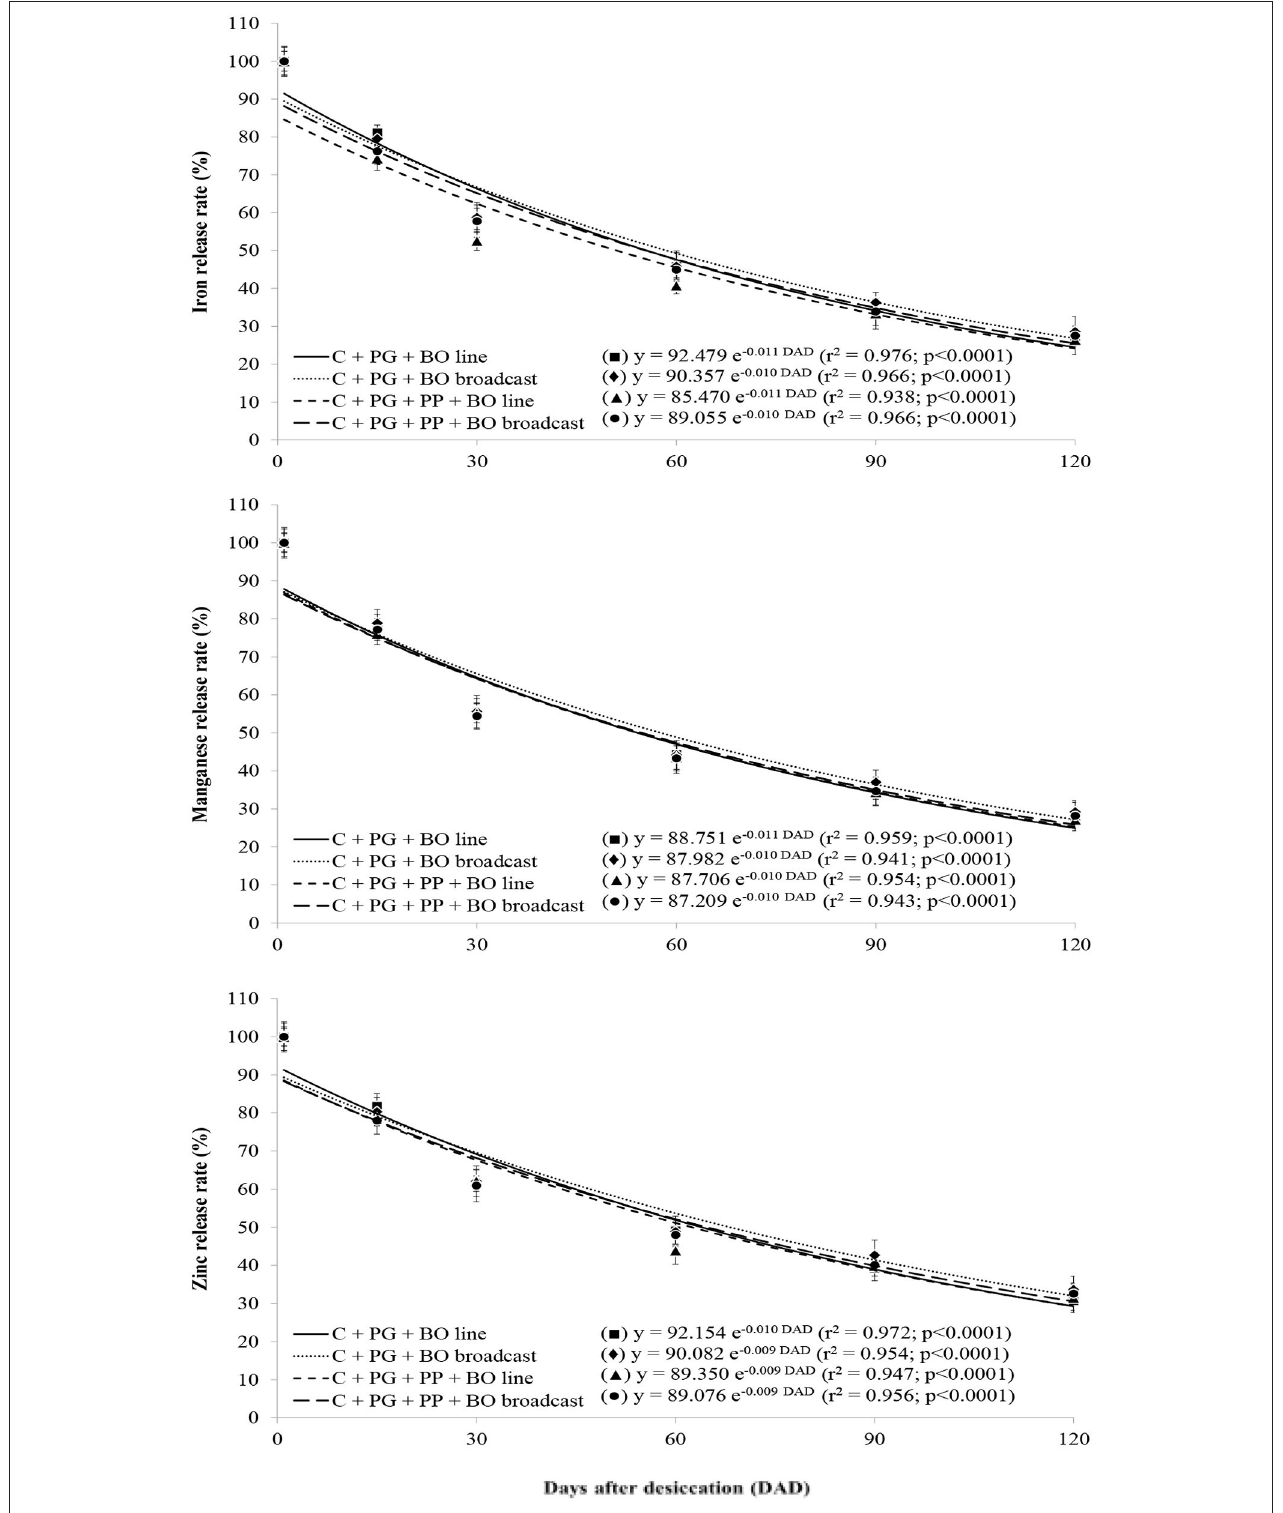
FIGURE 4 | Release rates of iron, manganese, and zinc in palisade grass (PG) intercropped with corn (C) and with corn and pigeon pea (PP) to silage with black oat (BO) oversown in lines and broadcast after grazing by lambs as a function of days after desiccation (mean of three growing seasons). Values are the mean of 12 replicates, and the associated error bar is ± 1 SE. Days after desiccation (DAD): days after pasture and weed desiccation with glyphosate herbicide, after grazing by lambs.